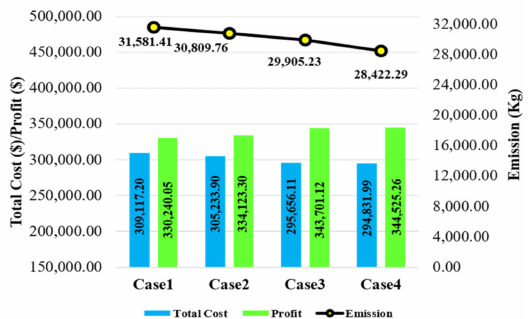
Figure 8. Comparison of cost, profit and emission for profit